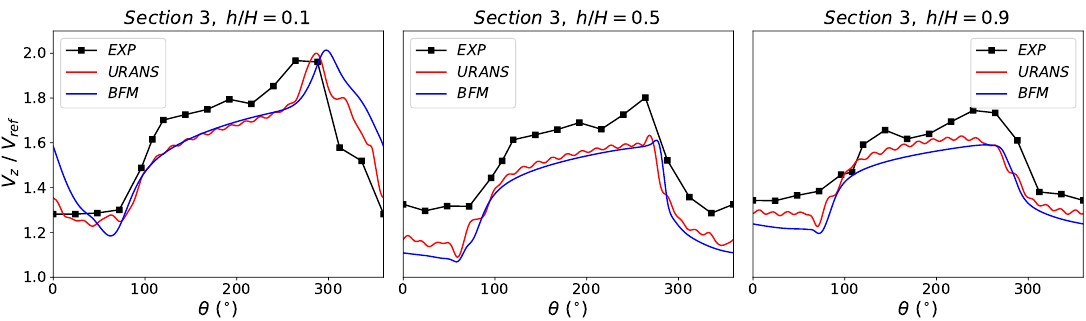
Figure 13. Azimuthal distribution of axial velocity in Section 3.